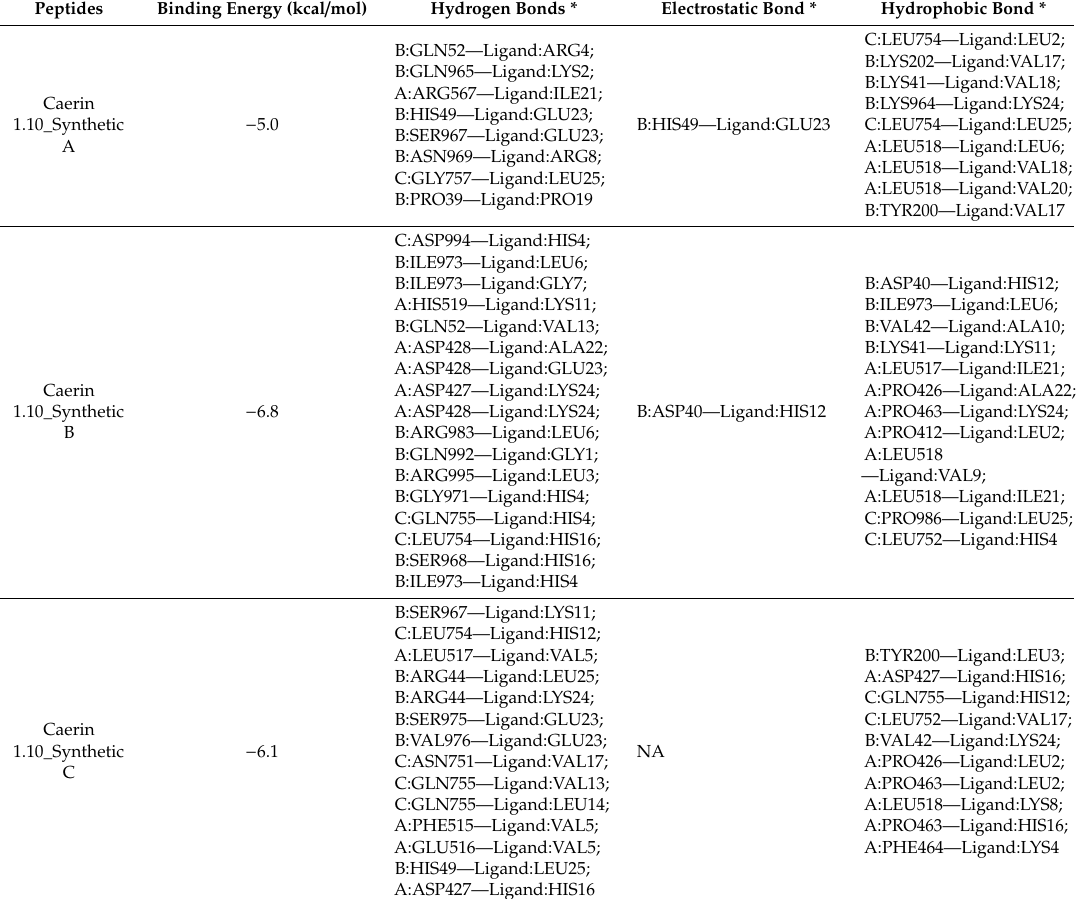
Table 8. Comparison of binding energy and interactions between modified caerins and Sgp.